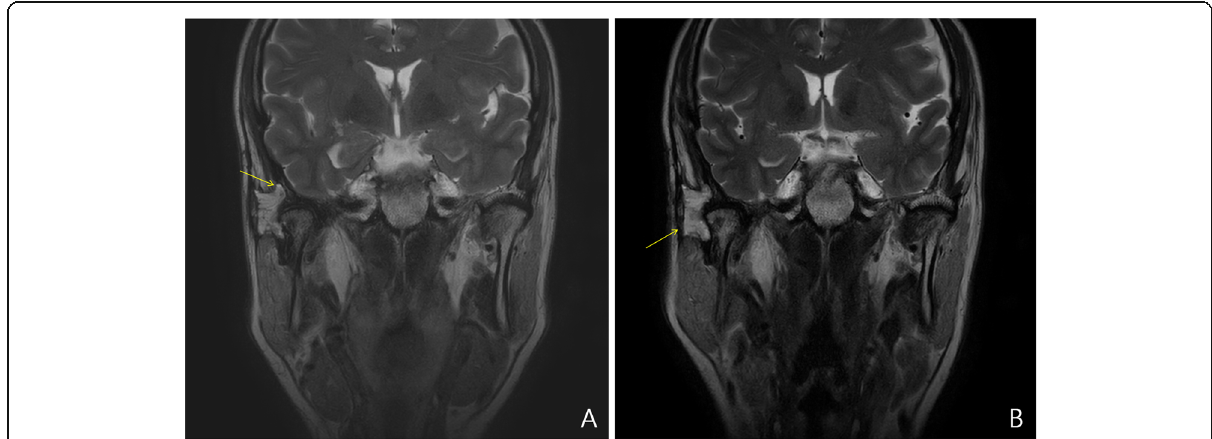
Fig. 4 Magnetic resonance imaging ( A ) coronal scan, 7 months postoperatively, shows the stable inguinal fat pad graft covering the temporal bone defect (arrow) and do not indicate chondroblastoma recurrence. At the 18-month follow-up visit, the magnetic resonance imaging ( B ) coronal view fails to reveal newly developed, abnormally enhanced lesions or restricted diffusion into the operation bed (arrow). There is